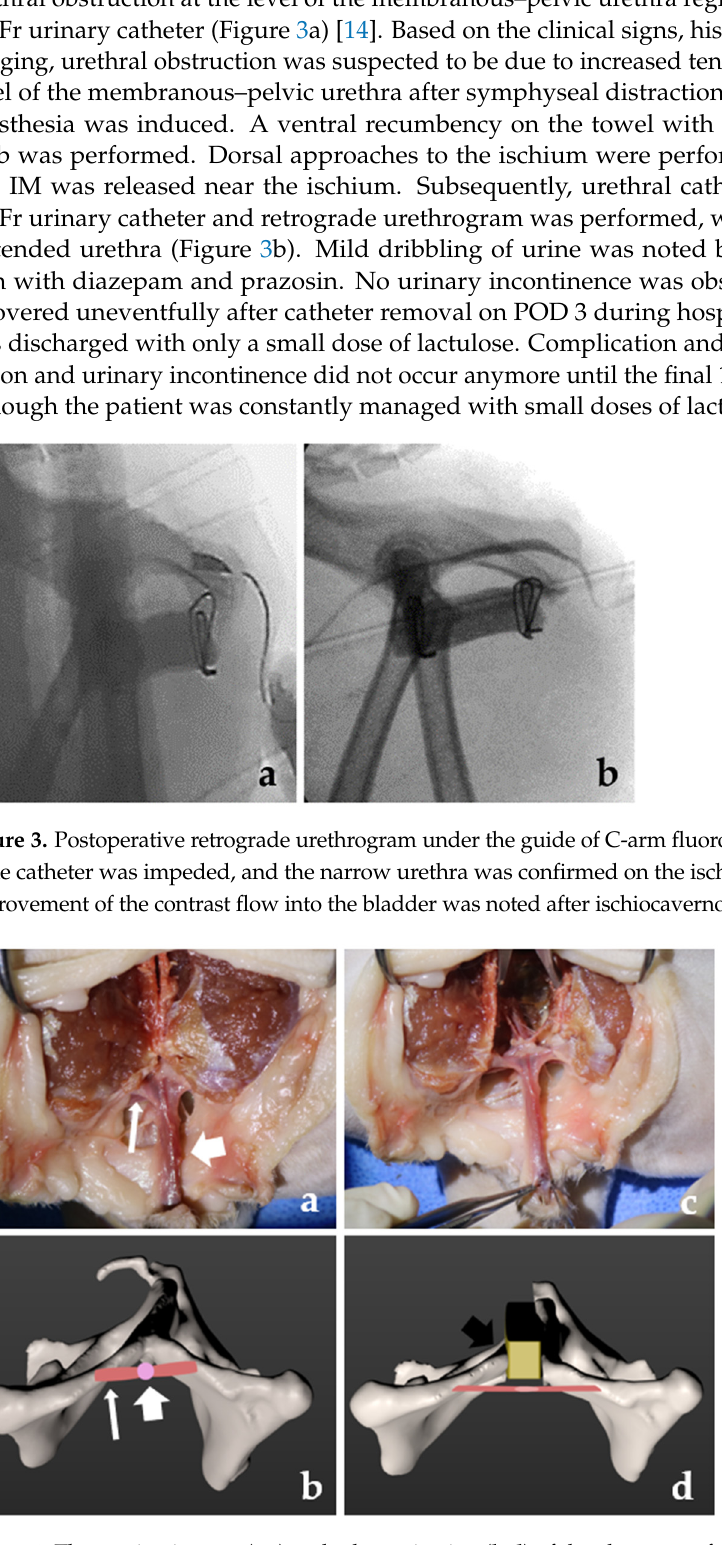
Figure 4. The ex vivo images ( a , c ) and schematization ( b , d ) of development of the urethra obstruction due to increased tension of ischiocavernosus muscle (white narrow arrow). The urethra (white broad arrow) could be stretched out and obstructed by distraction with an instrument or spacer (black